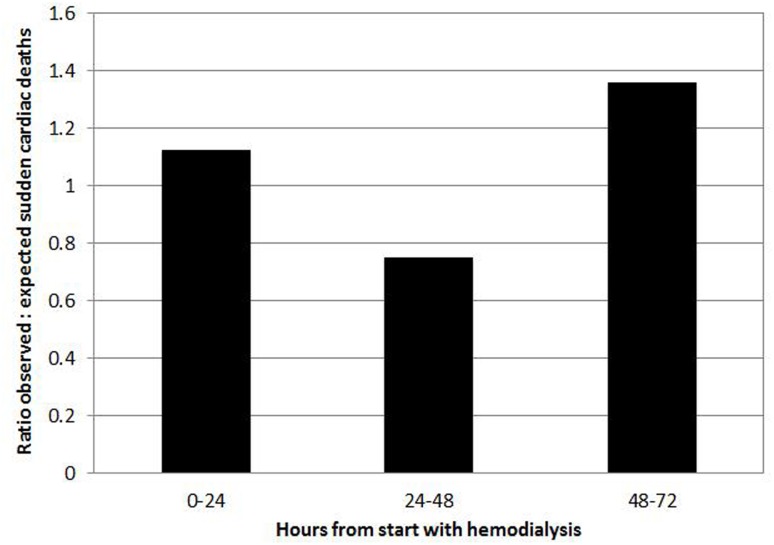
Ratio of observed to expected number of sudden cardiac death events for each 24 hour interval from the start of hemodialysis.